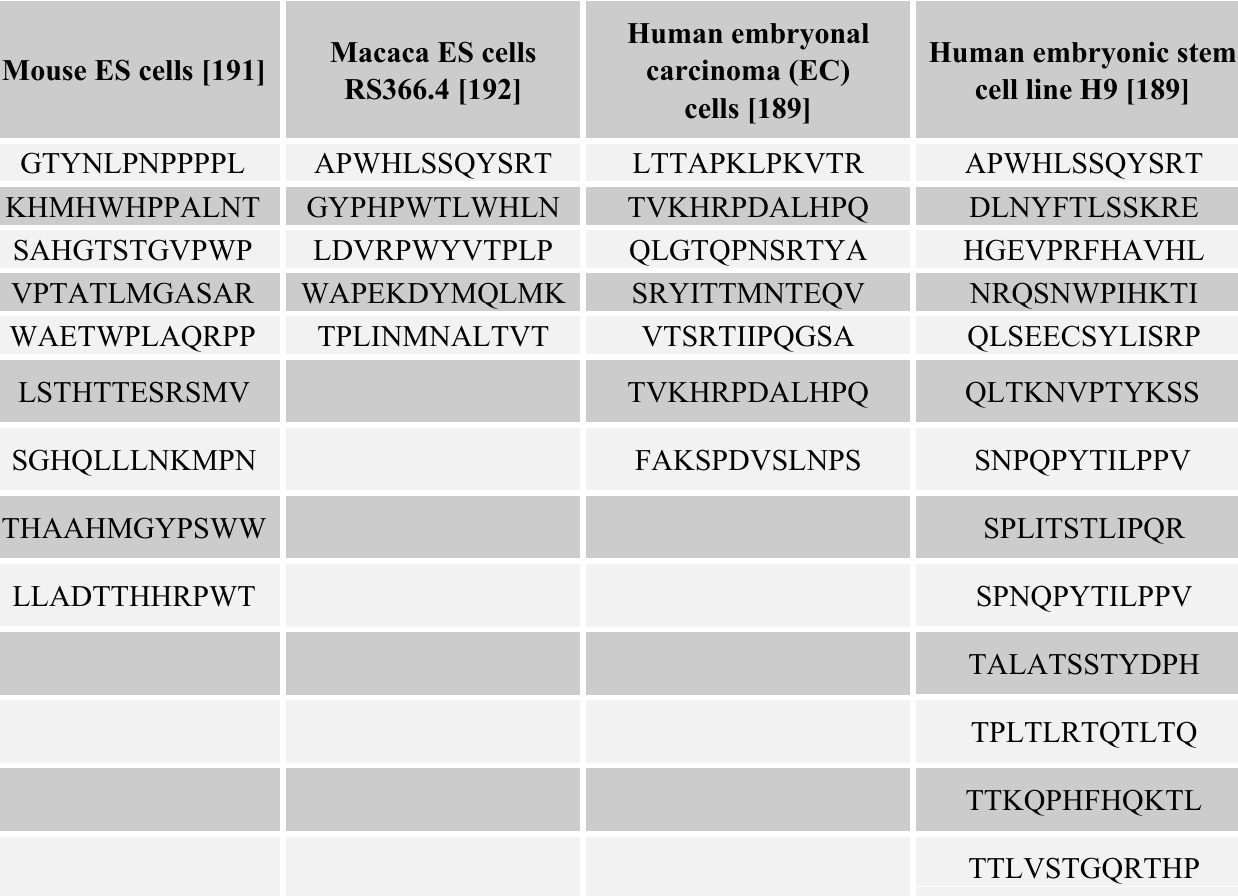
Table 4. ESC specific peptide